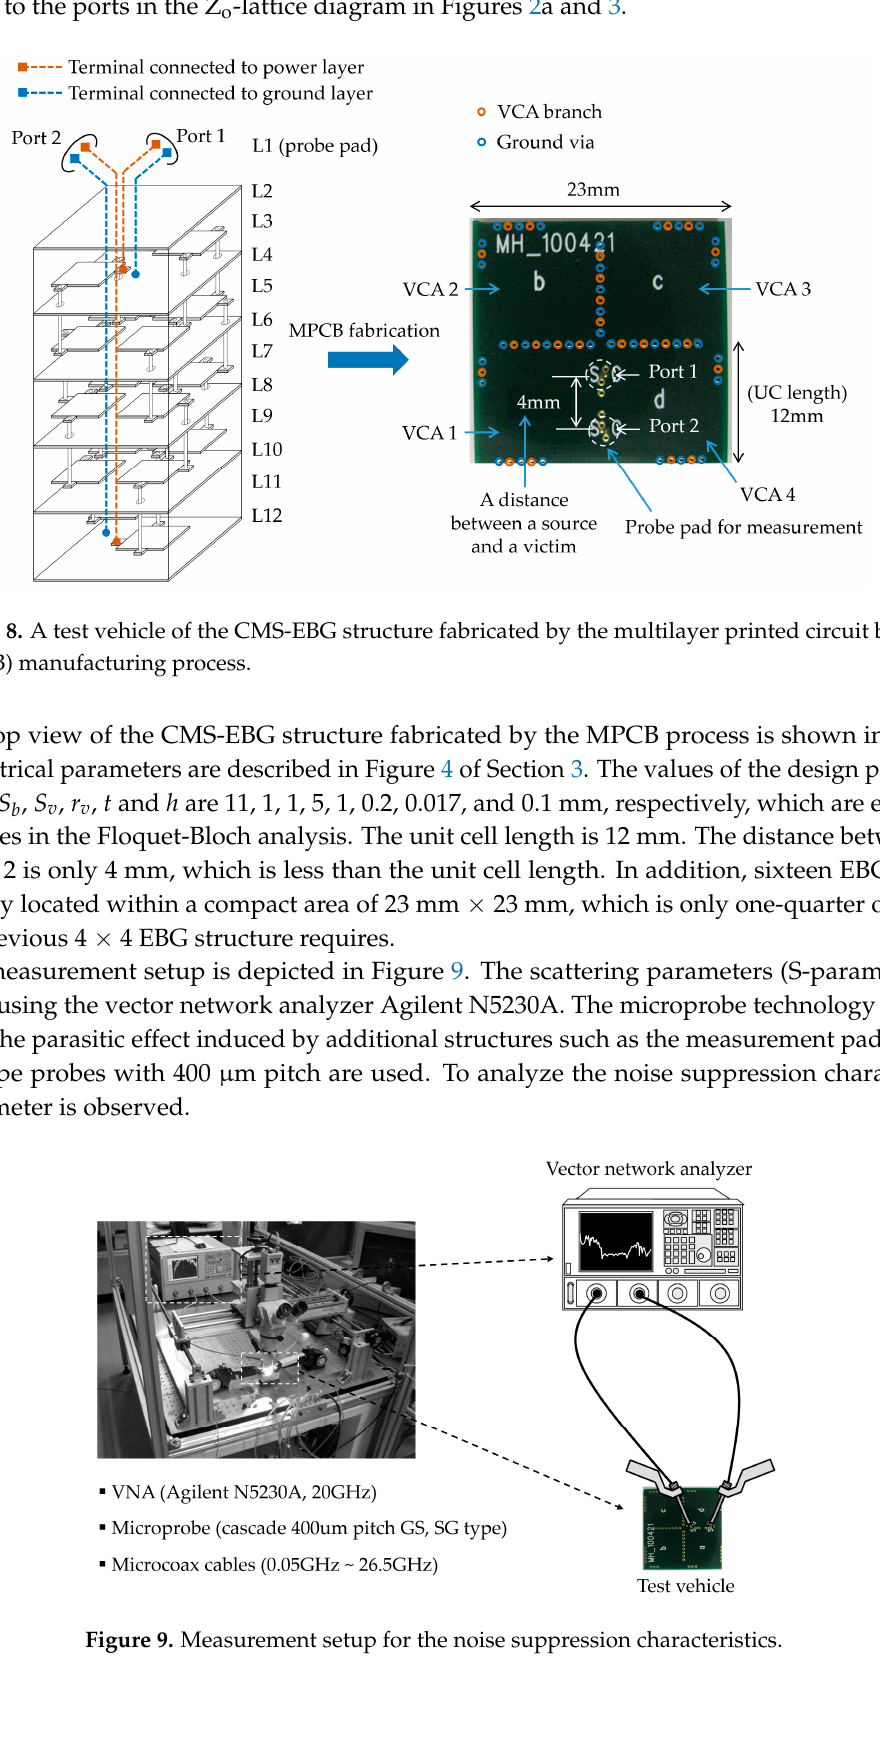
Figure 9. Measurement setup for the noise suppression characteristics.